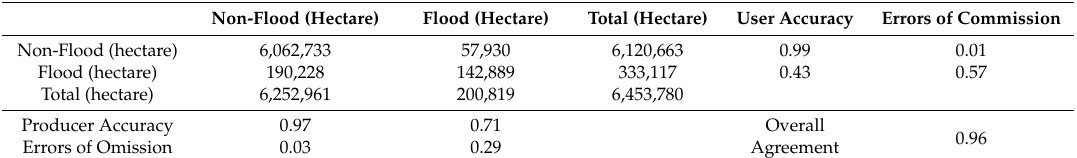
Table 2. The spatial agreement between SMAP and Sentinel-1 derived inundation acreage of Houston Flood.